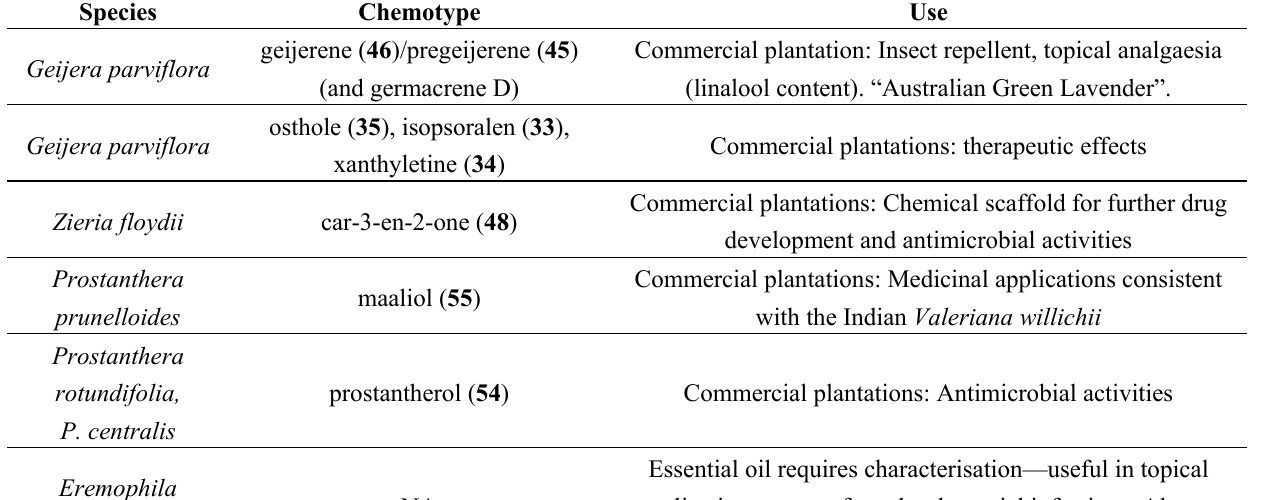
Table 3. Possible commercial scale applications from essential oil yielding flora in Australia. Species